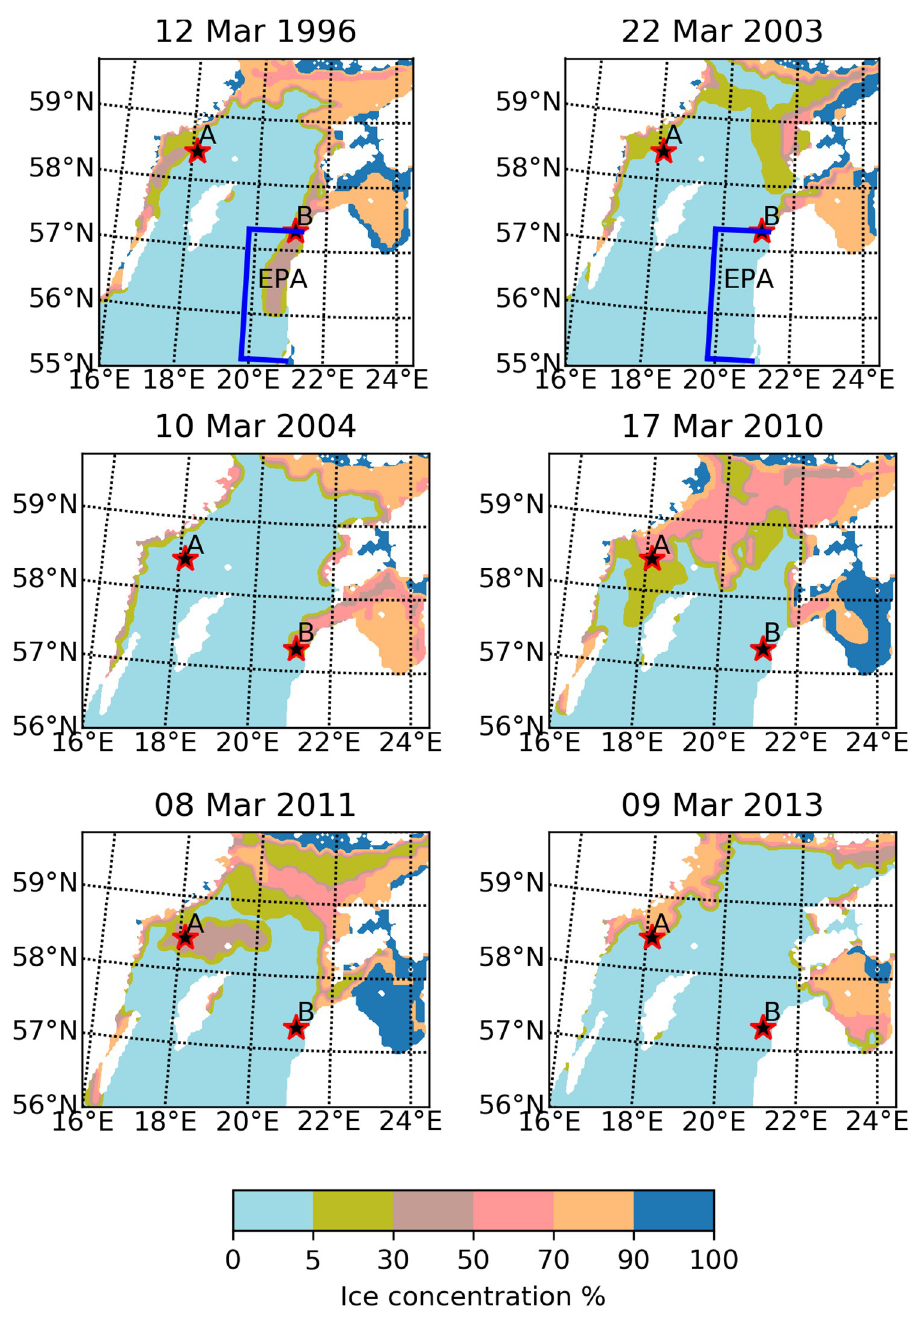
Fig 10. Sea ice concentration on the day of phytoplankton measurement. The measuring point is marked with a red-black star.